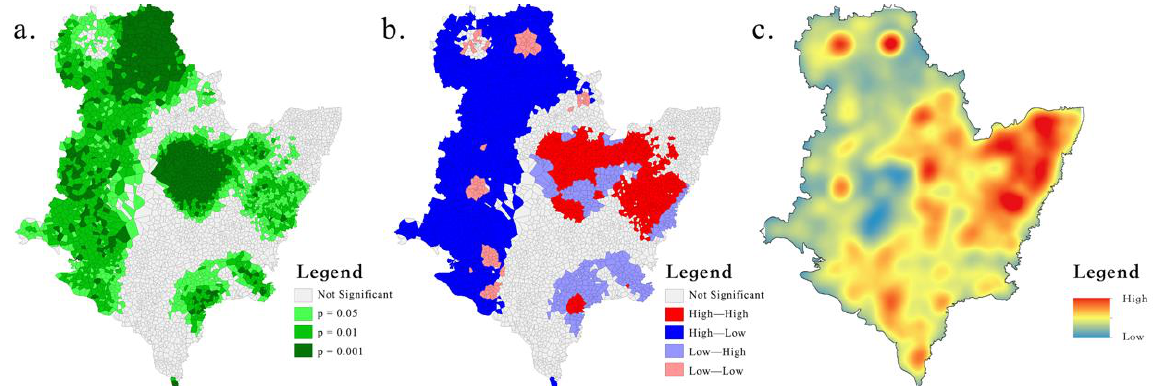
Figure 7. LISA cluster diagram of the spatial correlation between the suitability of human settle- ments and the distribution of rural residential areas: ( a ) Local autocorrelation p value distribution map; ( b ) local autocorrelation cluster diagram; ( c ) nuclear density map of rural residential areas.